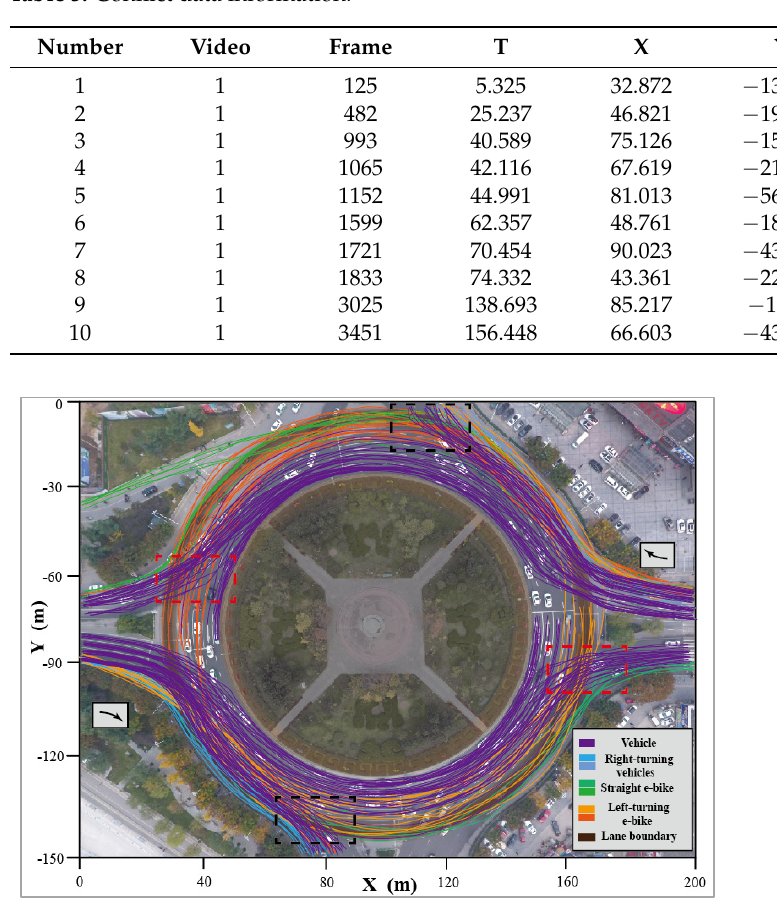
Figure 7. The trajectory of vehicles and e-bikes during a green light period at Chenyangzhai.